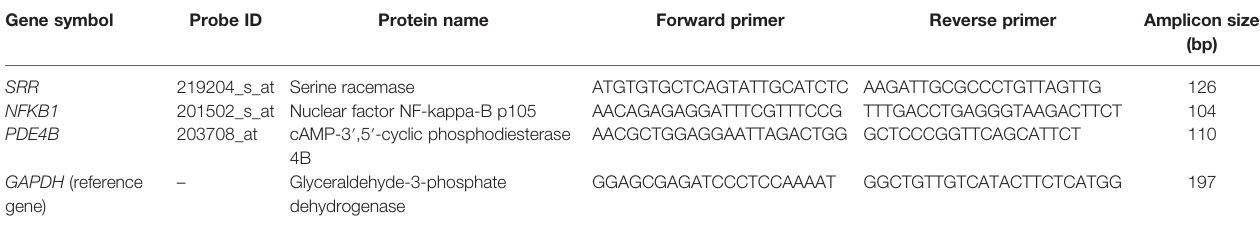
TABLE 1 | Primer sequences and amplicon size of the differentially expressed genes SRR , NFKB1 , and PDE4B used in the qPCR